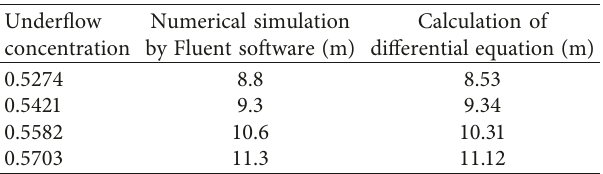
Figure 7: Photographs of industrial test. Table 4: Interface level results of numerical simulation and cal- culation of differential equation.